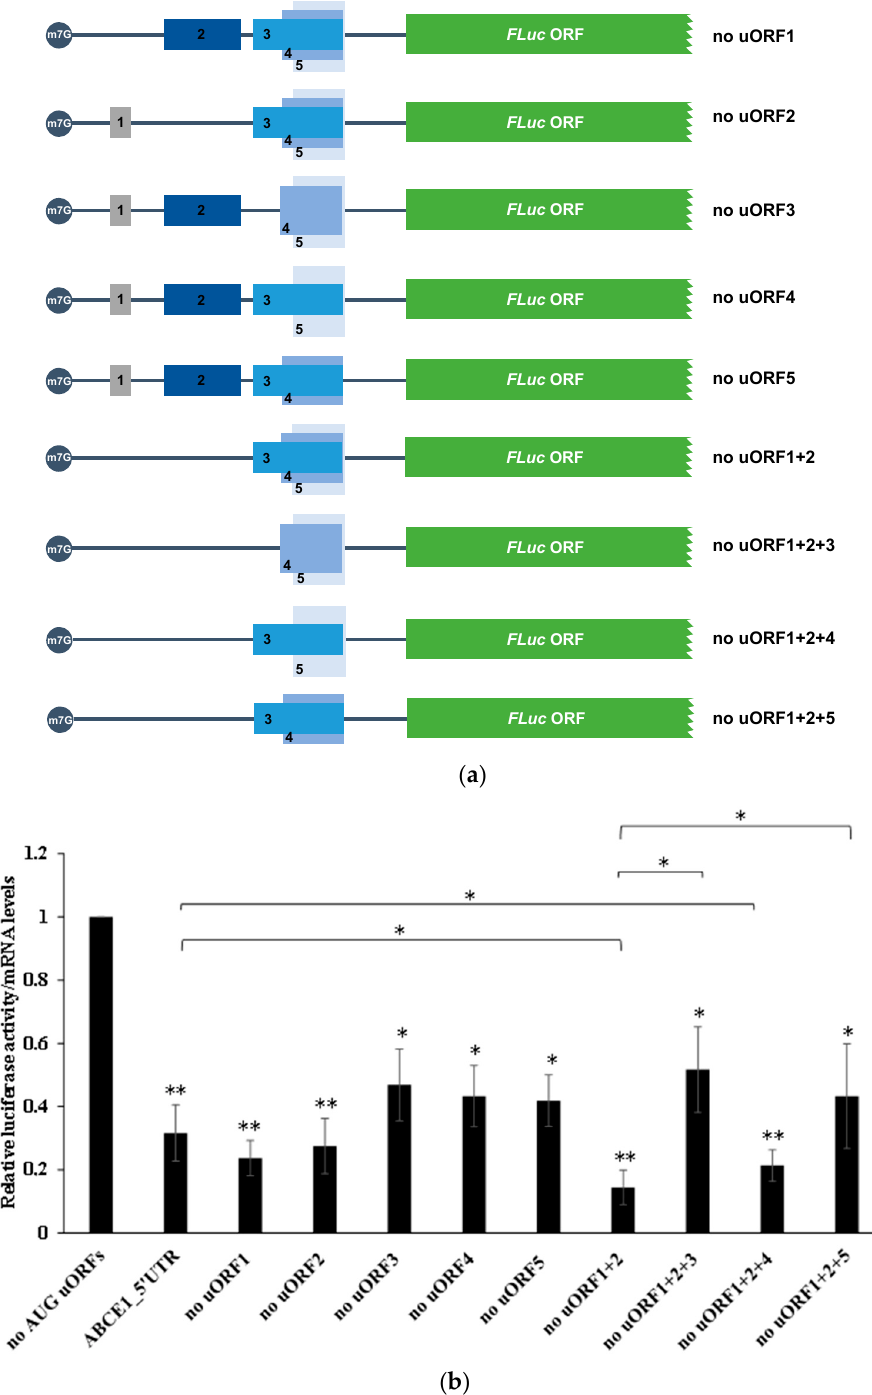
Figure 8. The ABCE1 uORF1 and uORF2 regulate the level of repression exerted by uORF3, or uORF5. ( a ) Schematic representation of the constructs, in which only one uAUG codon is mutated (ATG → TTG), obtaining the constructs “no uORF1”, “no uORF2”, “no uORF3”, “no uORF4”, and “no uORF5”, or different combinations of mutated and functional uORFs, originating the constructs named “no uORF1+2”, “no uORF1+2+3”, “no uORF1+2+4”, and “no uORF1+2+5”. The five non-AUG uORFs are present in these constructs but not represented in the figure to simplify the scheme. ( b ) HCT116 cells were transiently co-transfected with each one of the constructs described in ( b ), or ABCE1_5 (cid:48) UTR, or “no AUG uORFs” (both described in Figure 2a), and the pRL-TK plasmid. Expression of these constructs was analyzed as described in Figure 2b legend. The results are presented as mean ± SEM from at least three independent experiments. Student’s t-test was applied for statistical significance: p < 0.05 (*), and p < 0.01